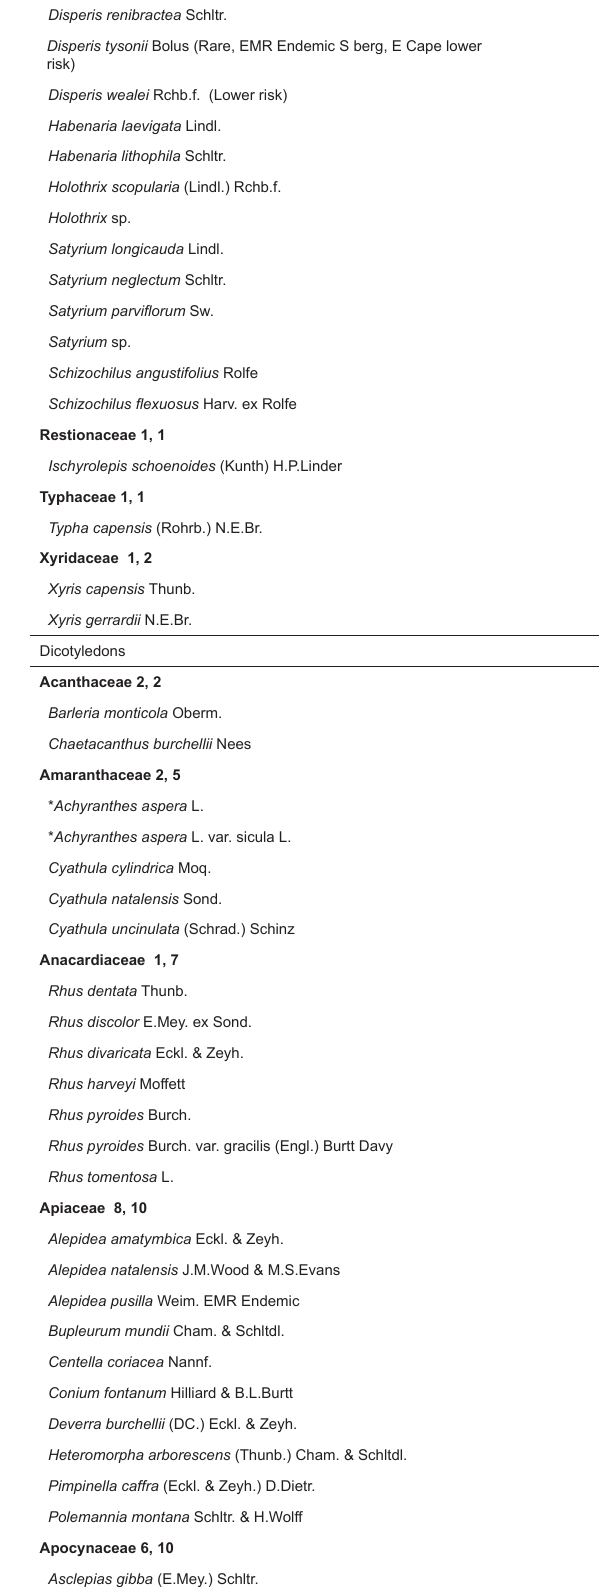
Eragrostis capensis (Thunb.) Trin. Eragrostis chloromelas Steud.